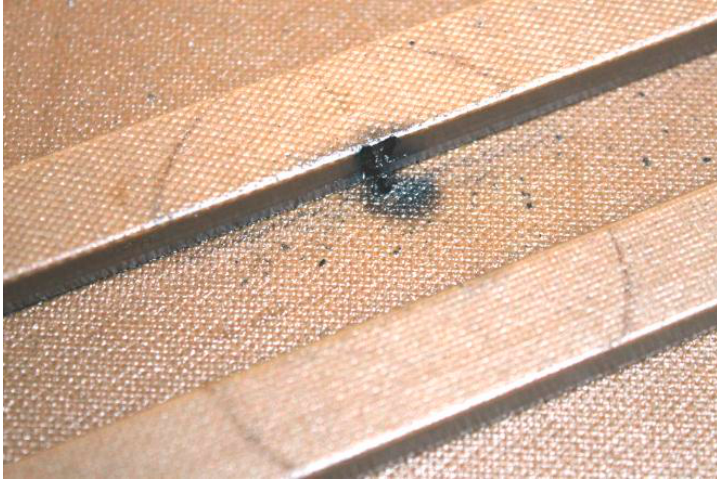
Figure 12. Traces of surface PD on an insulation sample with a moisture content of 5.7%.